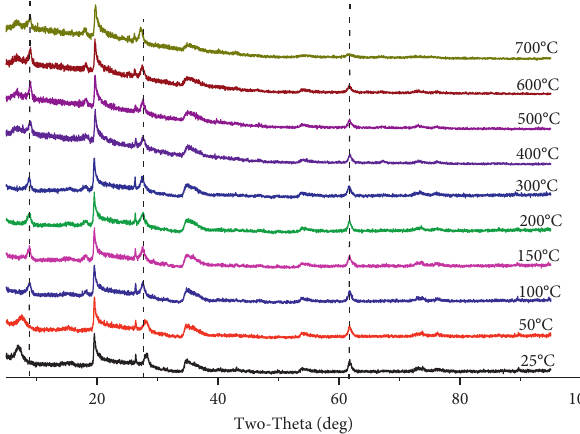
Figure 4: XRD patterns for Na-MMT and its thermal